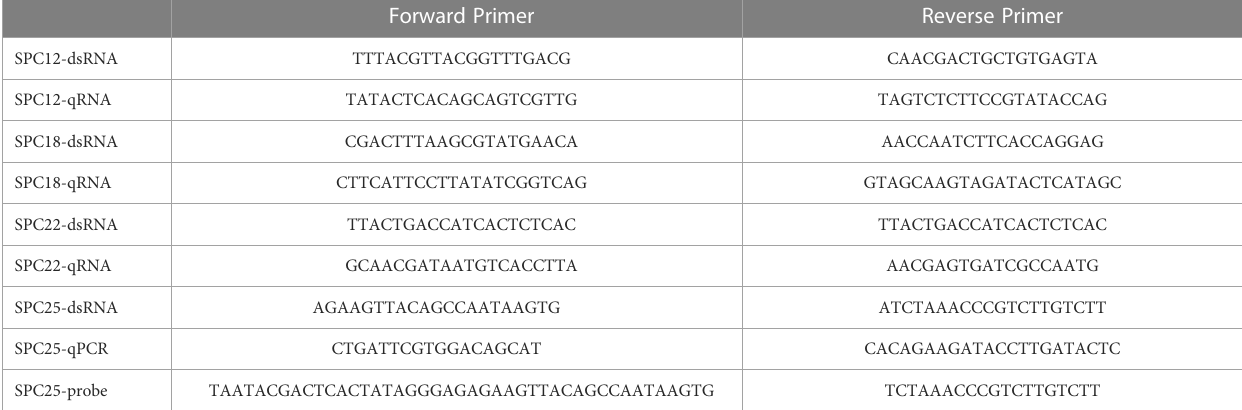
TABLE 1 List of primers used in this